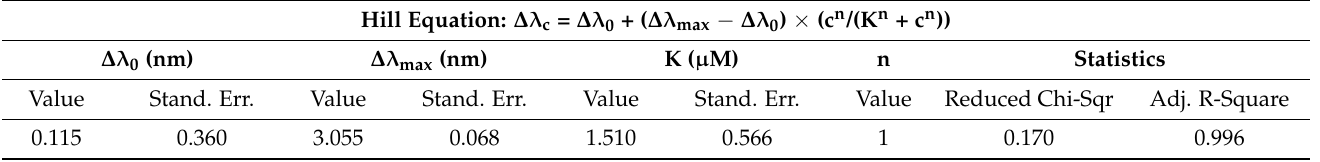
Table 1. Hill parameters of bovine serum albumin (BSA) detection.